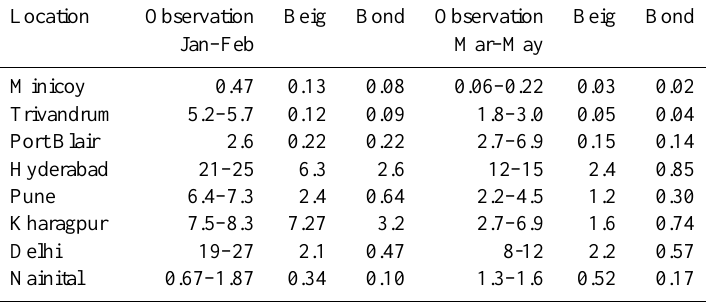
Table 2. Average mass of back carbon aerosols (inµgm − 3 ) from observations at eight locations in India (Beegum et al., 2009) for the different months and as simulated by the model for the Beig and Bond emissions for Year